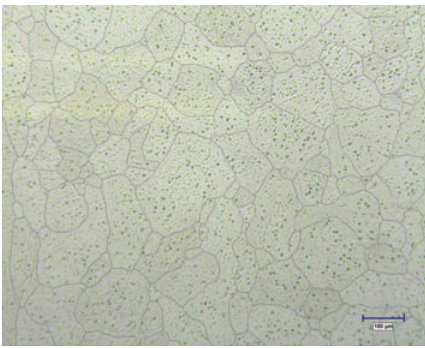
Figure 6: Microstructure of top surface of AZ31-B strip cast on segment III of copper substrate without any graphite